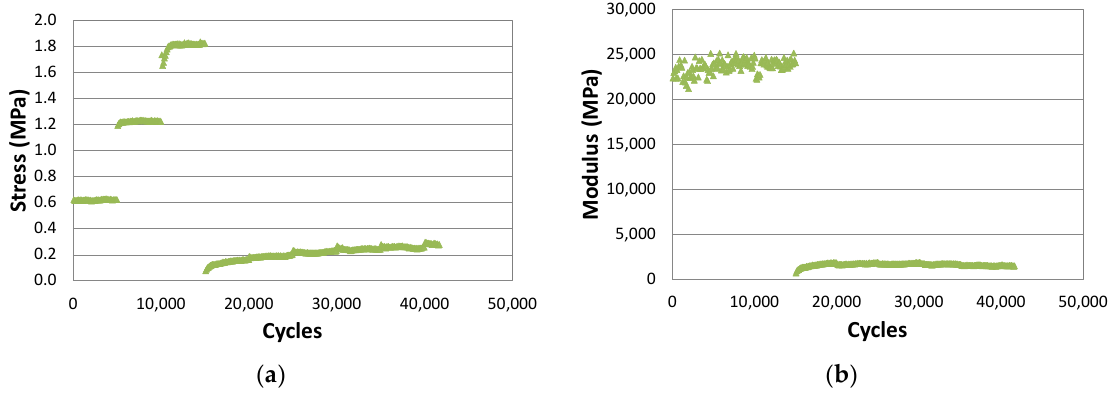
Figure 9. EBADE test results at − 5 °C and 10 Hz. ( a ) Stress and ( b ) modulus evolution with number of cycles. AC16 50/70 S mixture.